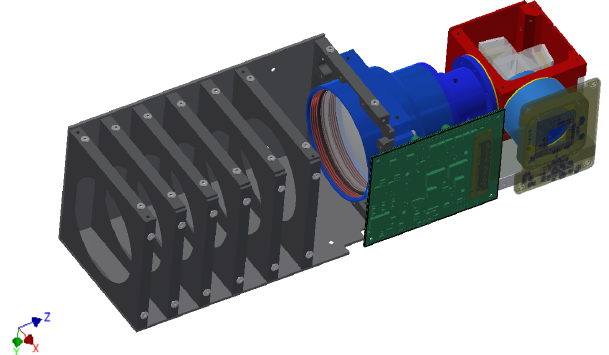
Figure 8. Design image of the instrument. The total length is 30cm and the front face about 10 × 10cm 2